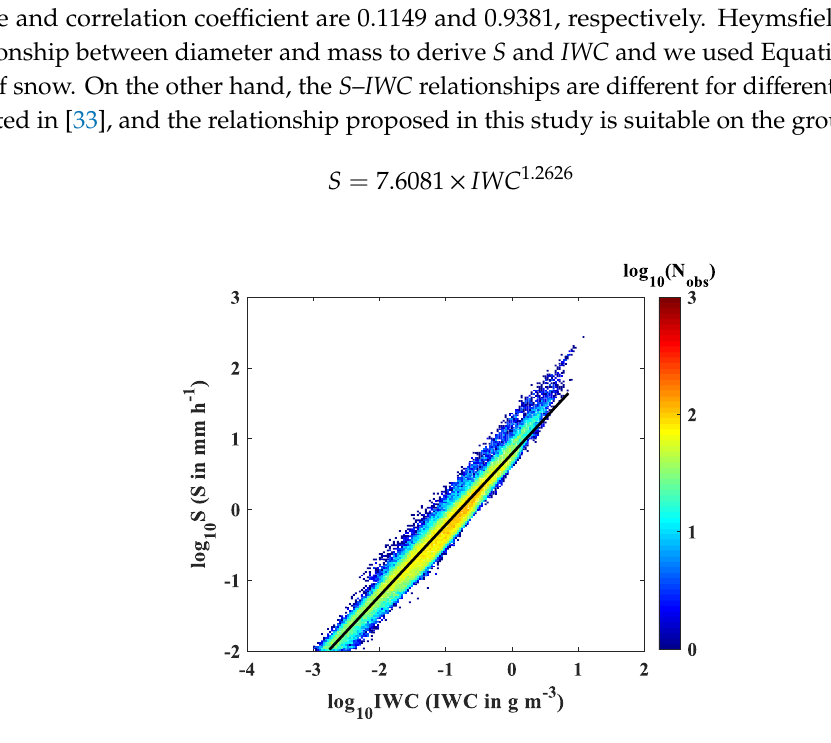
Table 2. Statistics of snow PSD parameters for total snowfall events: 𝜌 (g cm −3 ), 𝑙𝑜𝑔 10 𝐼𝑊𝐶 ( 𝐼𝑊𝐶 in